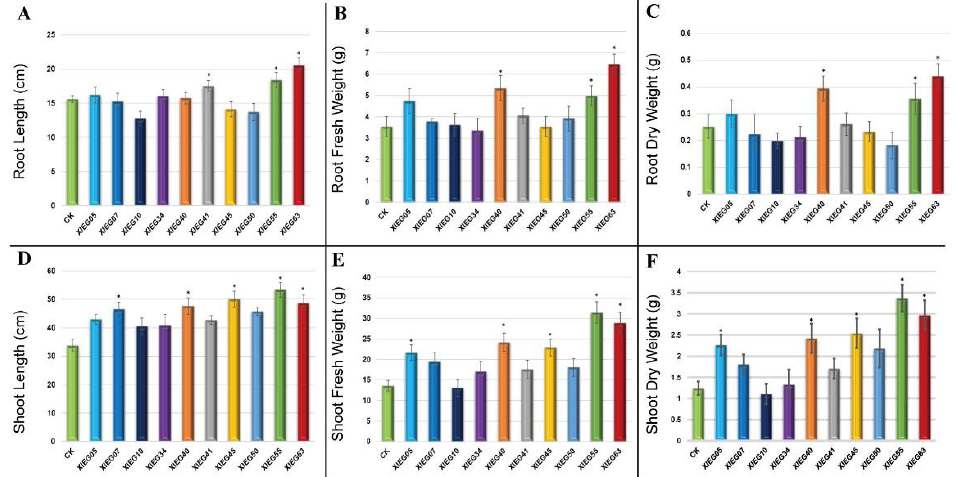
Figure 3 . The growth parameters of tomato 60 days after inoculation with the selected endophytic actinobacteria compared with the control. The data represent a mean of 10–12 replicates ± standard error (SE). The columns marked by ( “ * ” ) indicate significant differences based on one-way ANOVA, followed by Tukey ’ s HSD post hoc test for multiple comparisons at alpha level = 0.05. ( A ) Root length; ( B ) Root fresh weight; ( C ) Root dry weight; ( D ) Shoot length; ( E ) Shoot fresh weight; ( F ) Shoot dry weight.